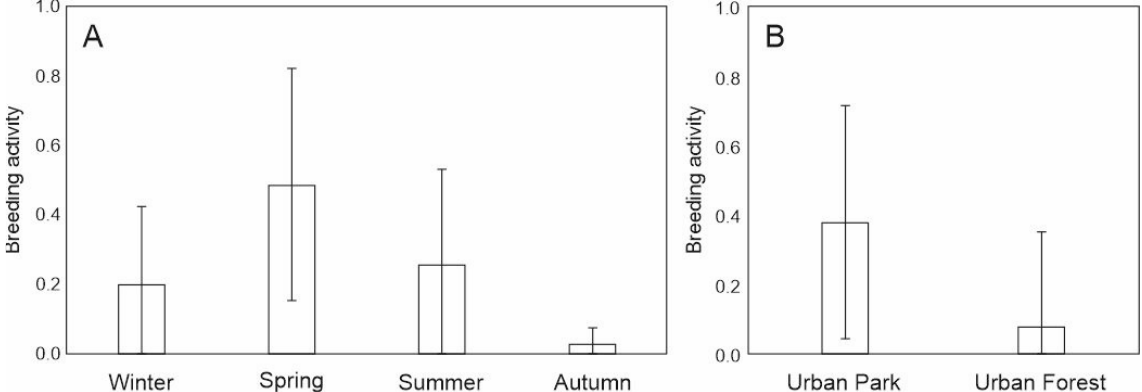
Figure 6. Frequency (±SE) of breeding (i.e., postoestrous and pregnant, lactating) adult female red squirrels with regard to ( A ) season and ( B ) study site. No statistically significant differences in pairwise comparisons using the Least Significant Difference test.